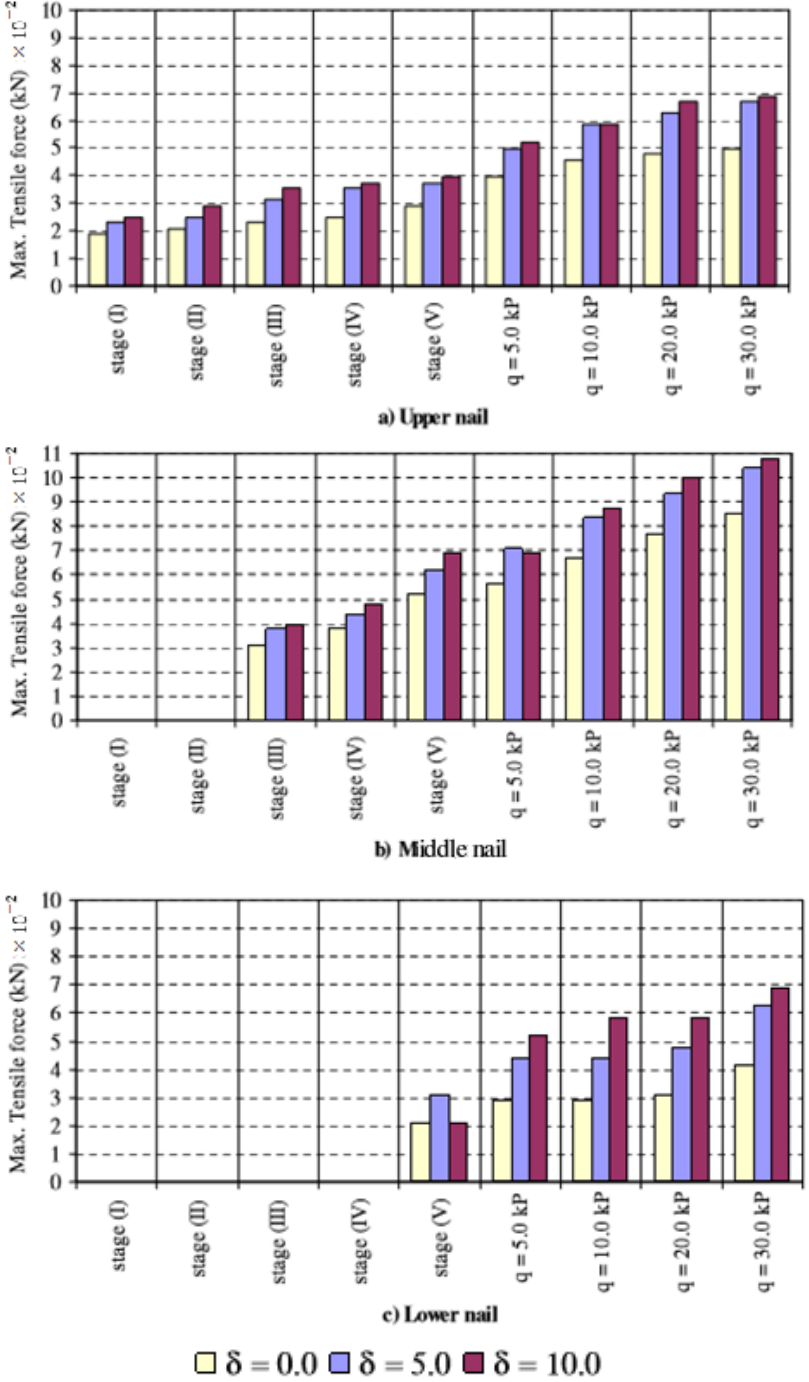
Figure 17. Influence of nail inclination on the maximum tensile force of the footing.